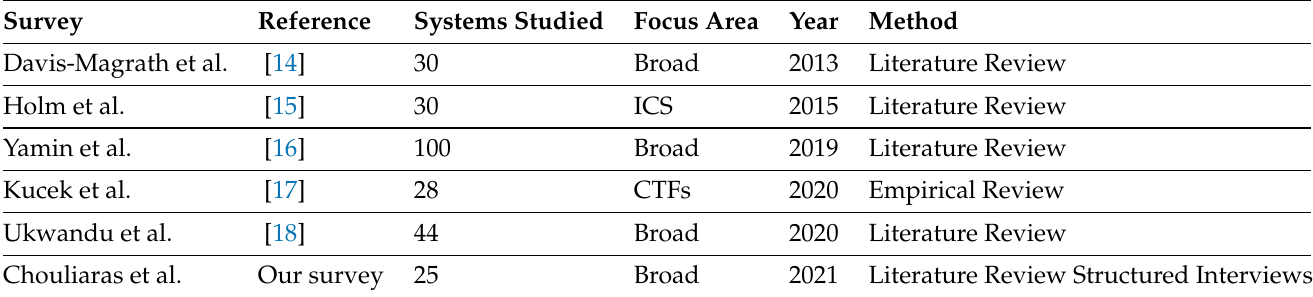
Table 1. Related surveys on Cyber Ranges and